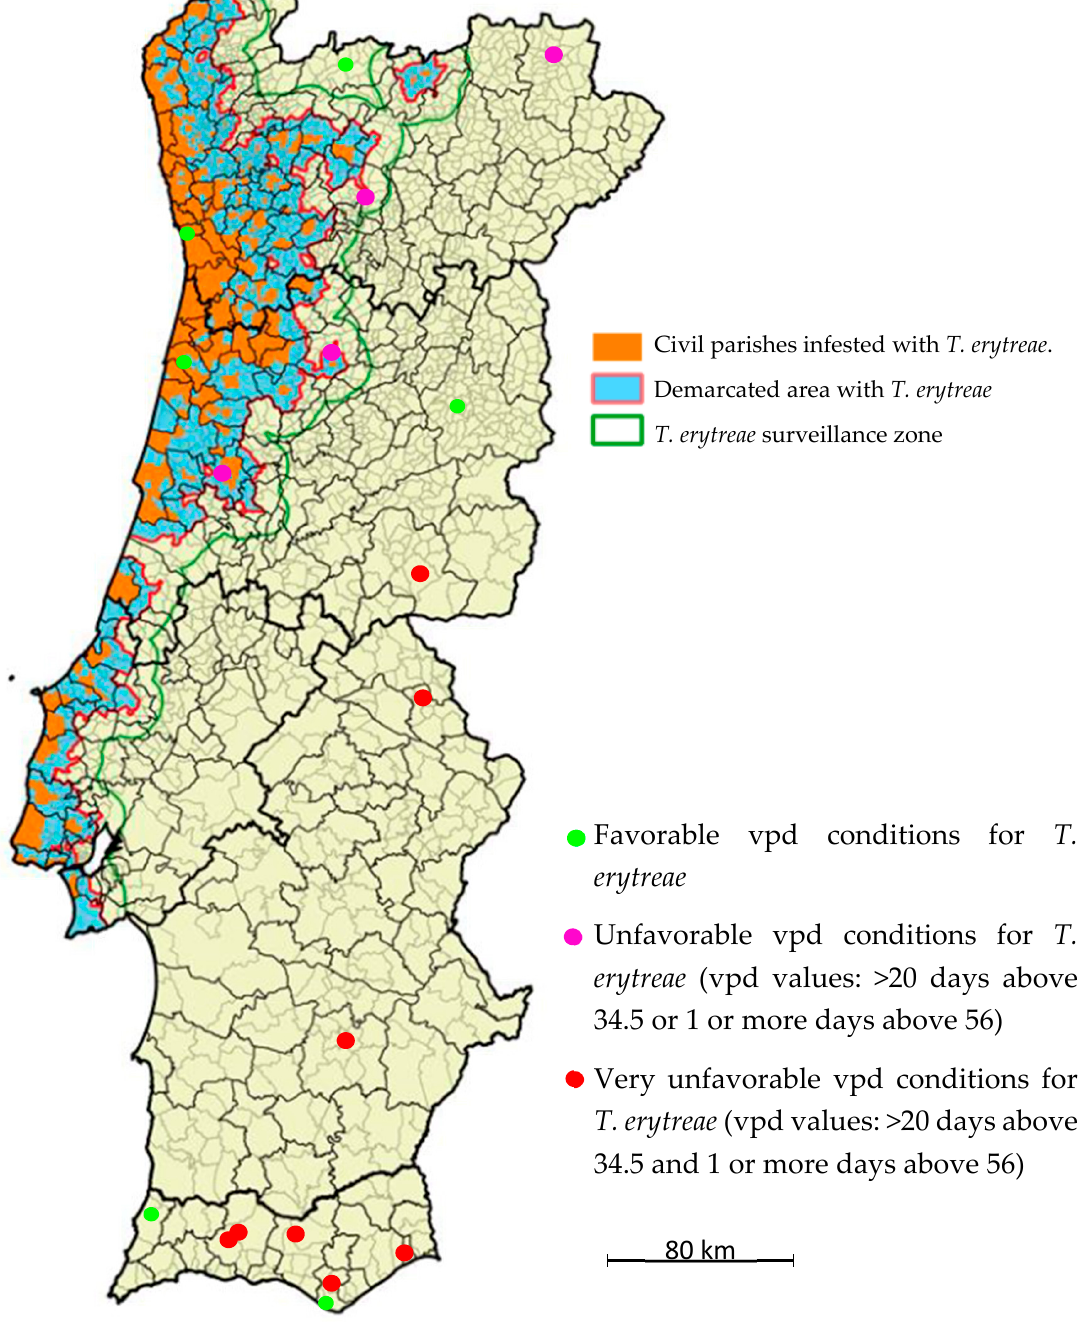
Figure 4. Distribution map of Trioza erytreae in mainland Portugal. The delimitation of the “Infested Zone” is based on the civil parishes where T. erytreae was detected. A “buffer zone” was added to this zone, surrounding a 3 km radius considering the flight capacity of the insect. A “Surveillance Zone” of 10 km radius was also defined around the Demarcated Zone (Infested Area + Buffer Zone). Available online by the General Directorate of Food and Veterinary of the Portuguese Ministry of Agriculture [4] (http: // www.dgv.min-agricultura.pt / portal / page / portal / DGV / genericos?generico = 221911&cboui =